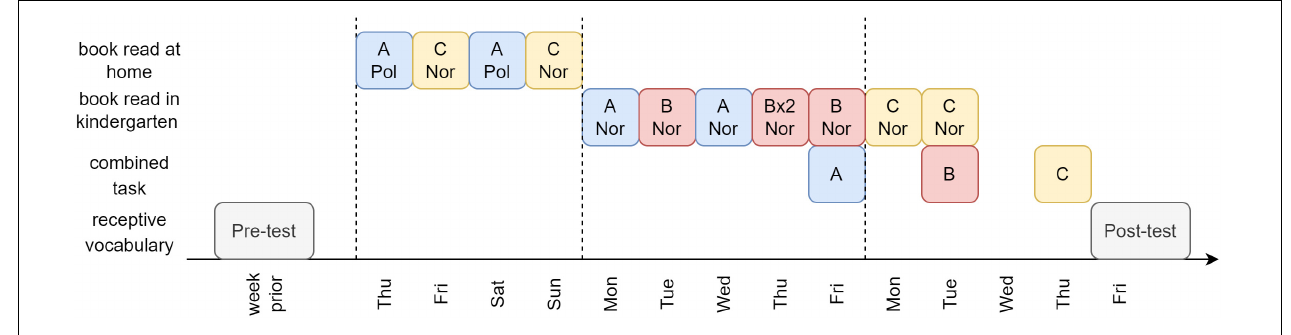
FIGURE 2 | Example of a book-reading and testing schedule. “Combined task” refers to the combined story comprehension and expressive vocabulary task.